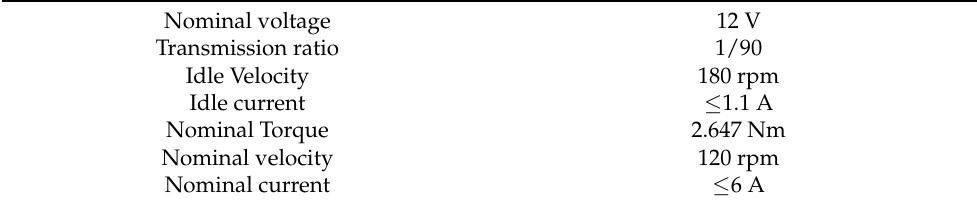
Table 3. DC motor parameters set in direct dynamics simulations.